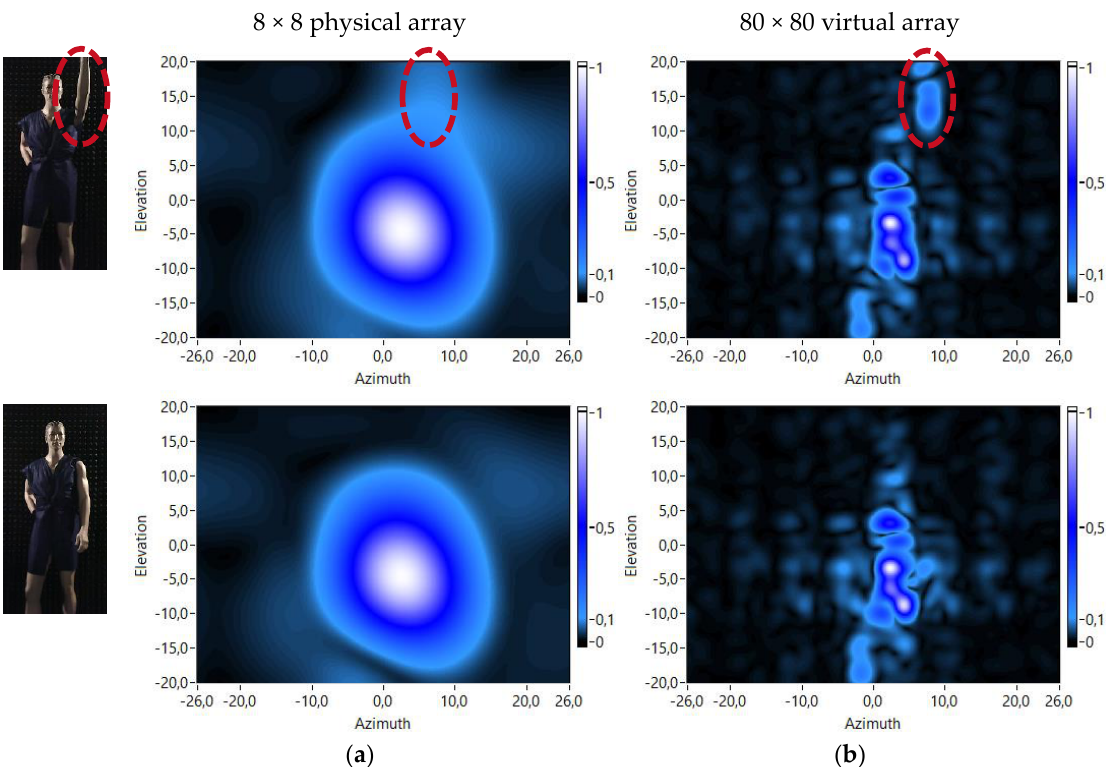
Figure 11. Array responses: ( a ) 8 × 8 physical array; and ( b ) 80 × 80 virtual array.